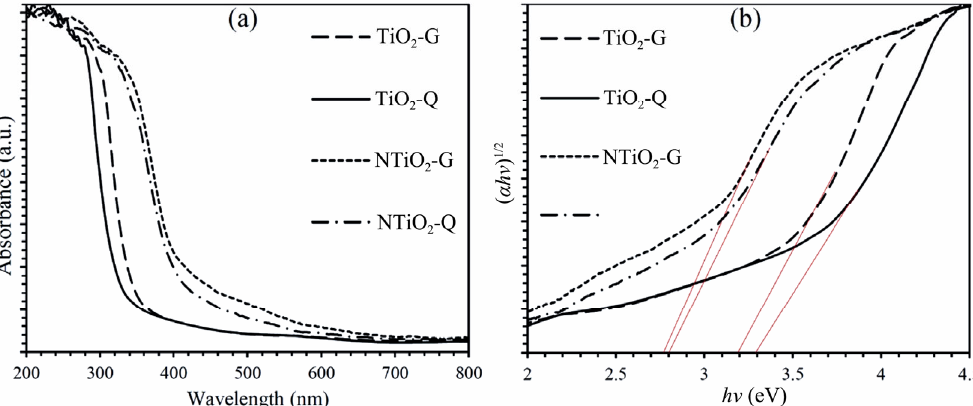
Fig. 5 (a) UV–Vis absorption spectra of the prepared thin films samples and (b) band gap energy calculation from Tauc